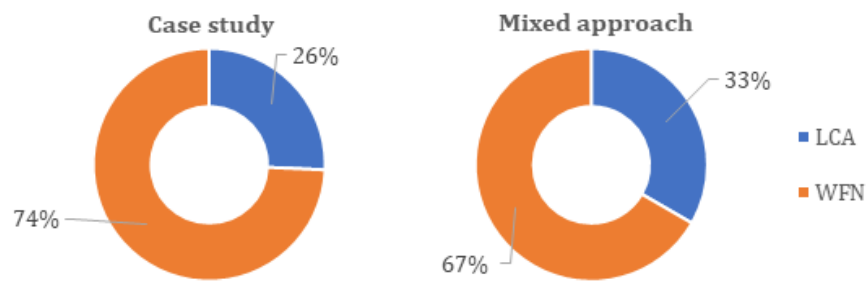
Figure 4. Approaches used in the case studies and mixed approaches reviewed.